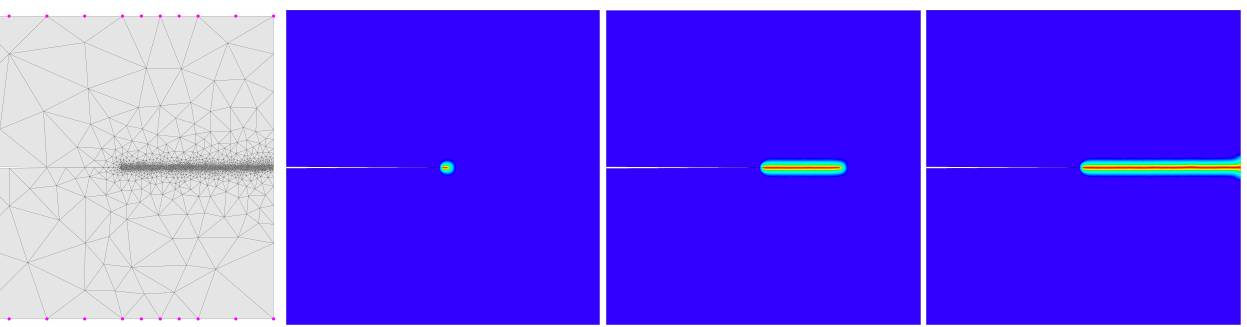
Figure 10. Single-edge notched test (SENT). Geometry and contour plots of the fracture phase-field d for different loading states up to final failure using FEM with 3-noded linear triangular